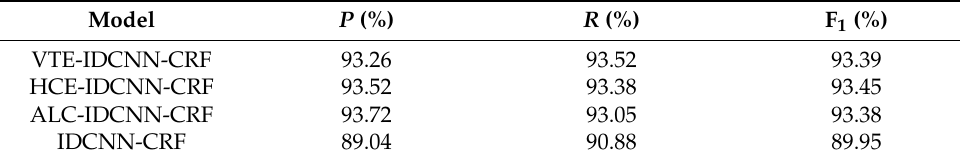
Table 4. The experimental results based on the IDCNN-CRF model.